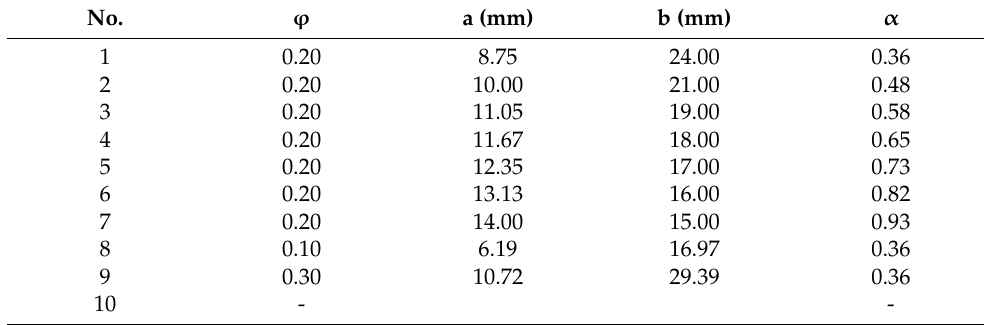
Table 3. Summary of the models corresponding to seafloor massive sulfide rocks. a denotes the length of the minor axes of massive sulfides; b denotes the lengths of the long axes of massive sulfides; α denotes the aspect ratios of massive